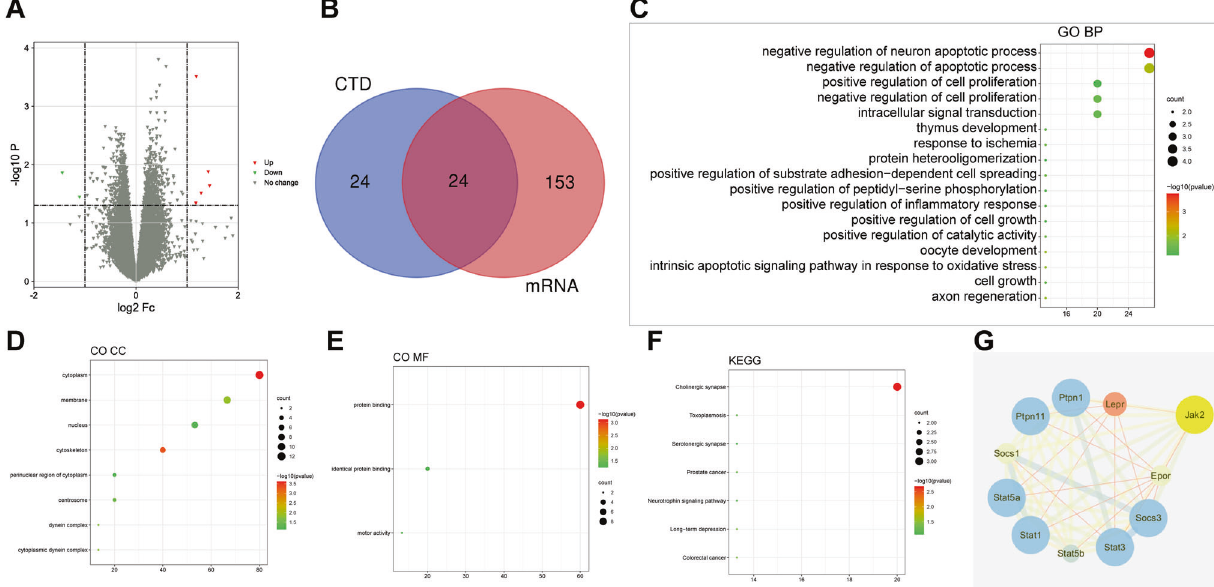
Fig. 1 Twenty-four target genes related to corneal allograft rejection are screened through transcriptome high-throughput sequencing. A Differential expression of mRNAs in corneal allograft rejection and normal samples. The green dots indicate downregulation, the red dots indicate upregulation, and the gray dots indicate no signi fi cant difference. The X -axis represents the logarithm (log 2 ) of the FoldChange between different groups, i.e., log 2 (FC). The Y -axis represents the logarithm ( − log 10 ) of the p value, namely − log 10 ( p value). B The Venn diagram for the retrieval results of the two databases. C GO functional analysis of DEmRNA at the biological process level. D The GO function of DEmRNA was analyzed at the cellular component level. E GO functional analysis of DEmRNA at the molecular function level. F The size of dots indicates the number of selected genes, and the color represents the p value of enrichment analysis. G Network for candidate target gene interaction (node represents protein, edge represents protein association, and colors and shapes represent degree value and Combine Score